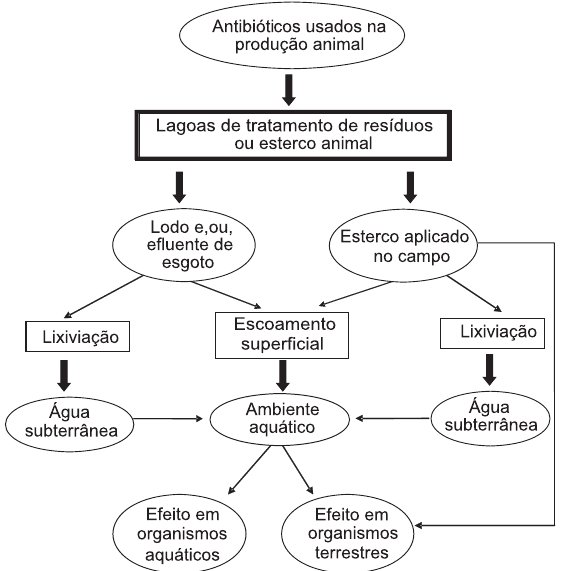
Figura 1. Principais vias de exposição ambiental aos fármacos de uso veterinário (Adaptado de Sarmah et